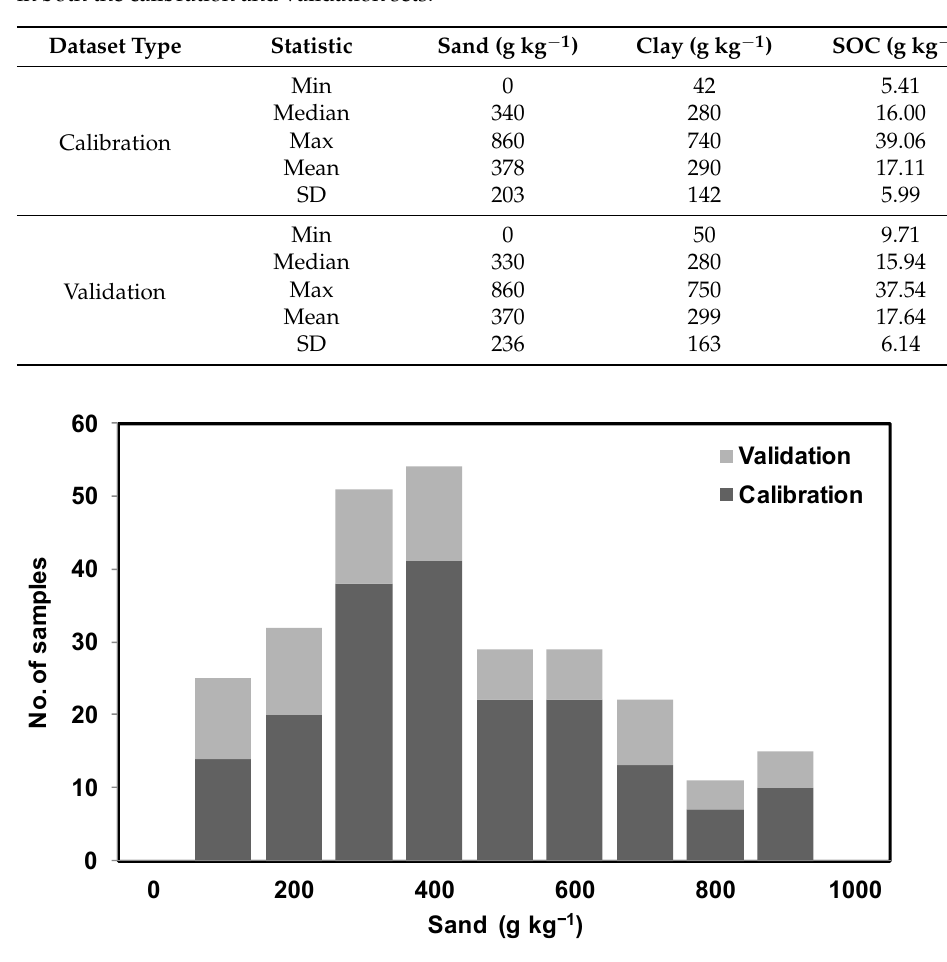
Figure 6. Illustration of distribution of sand content using stacked histogram with two categorical variables (calibration data and validation data).